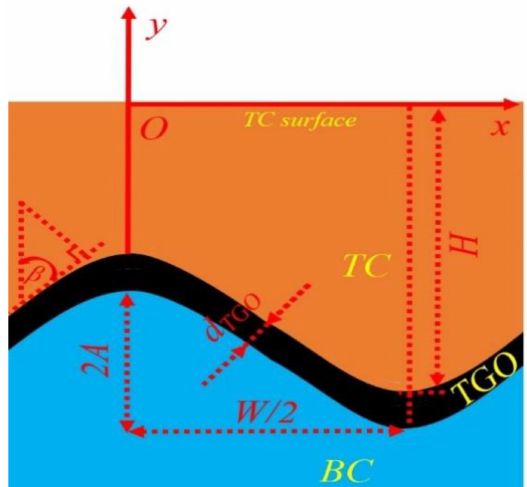
Figure 1. A schematic diagram of APS-TBC layers and geometry parameters used in cracking driving force analysis.